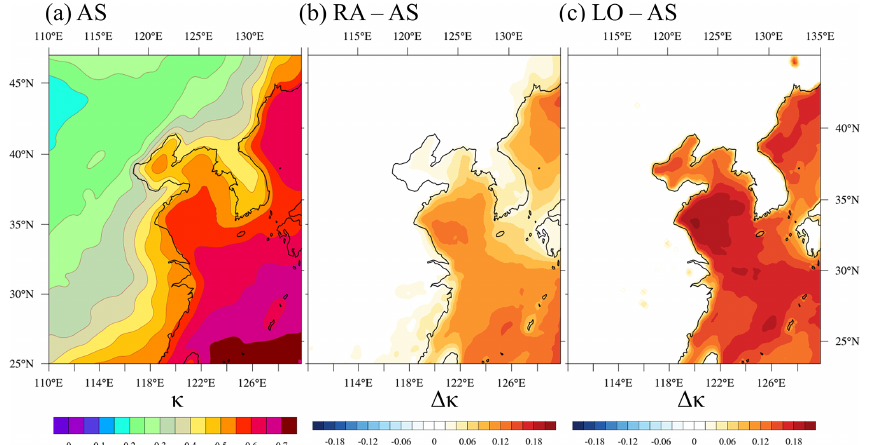
Figure 3. (a) Spatial distribution of the hygroscopicity parameter ( κ ) in the accumulation mode simulated by AS, and the difference in κ (b) between RA and AS and (c) between LO and AS, at the